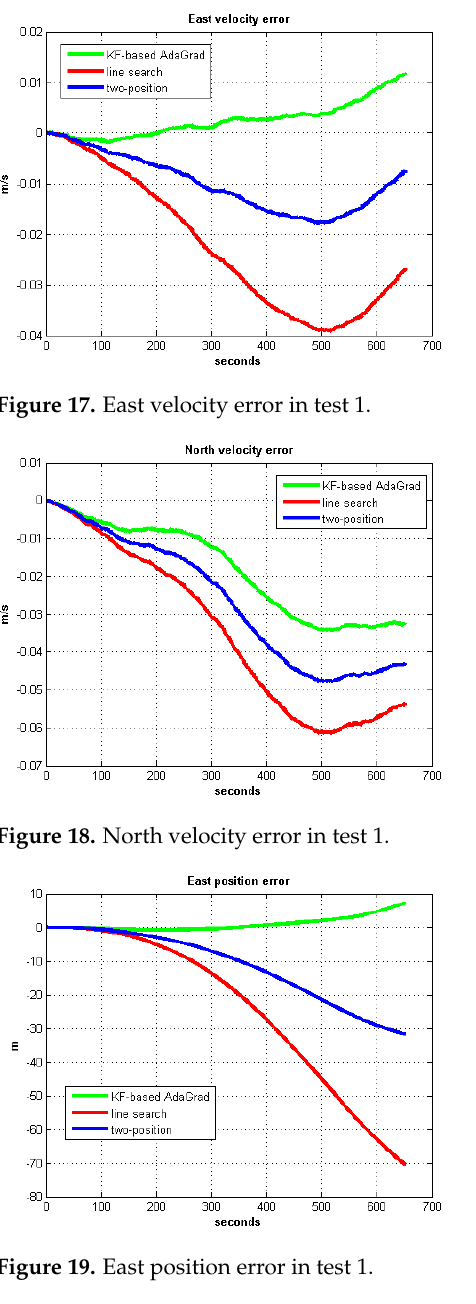
Figure 19. East position error in test 1.